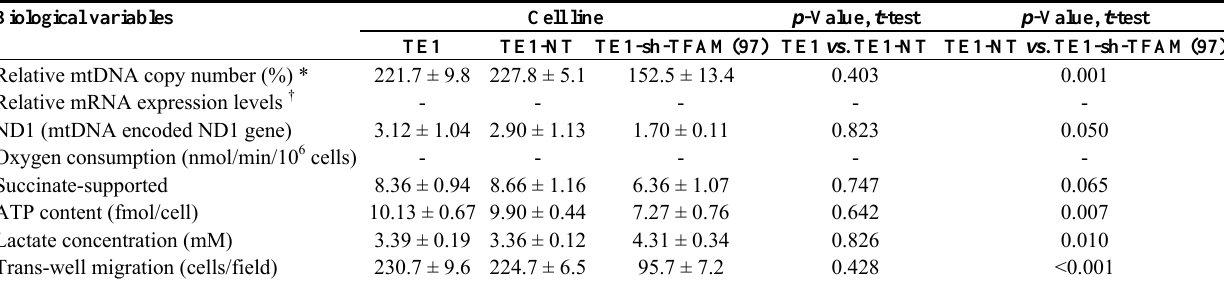
Table 2. Comparison of the relative mtDNA copy number, bioenergetic function and invasion activity of the parental TE1, control TE1-NT and TFAM knockdown TE1-sh-TFAM(97) cell